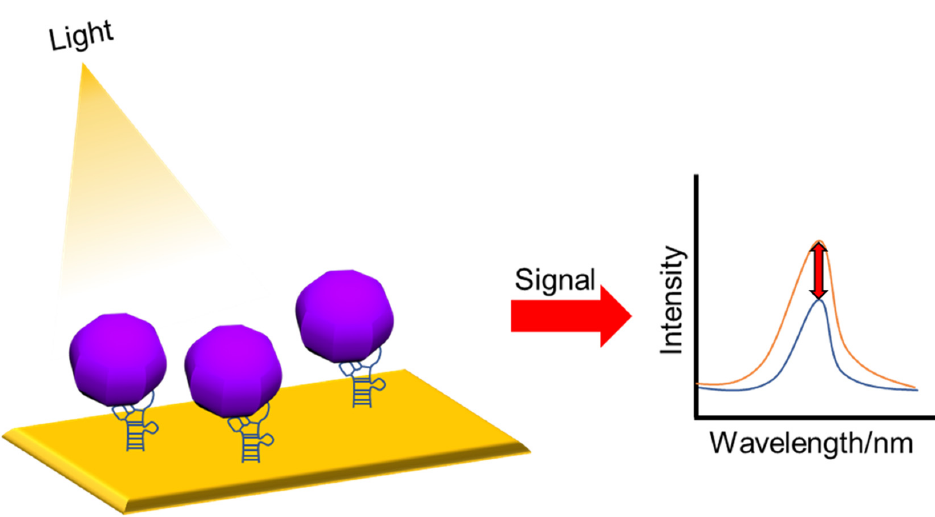
Figure 6. Schematic diagram of an optical sensor. Changes in intensity signals before and after bind-